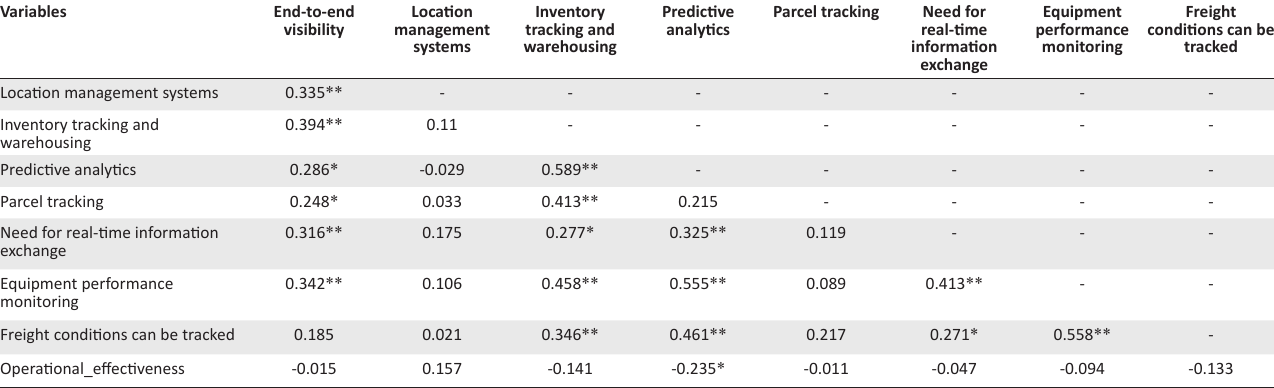
TABLE 4: Correlations: Operational effectiveness and drivers of internet of things. Variables